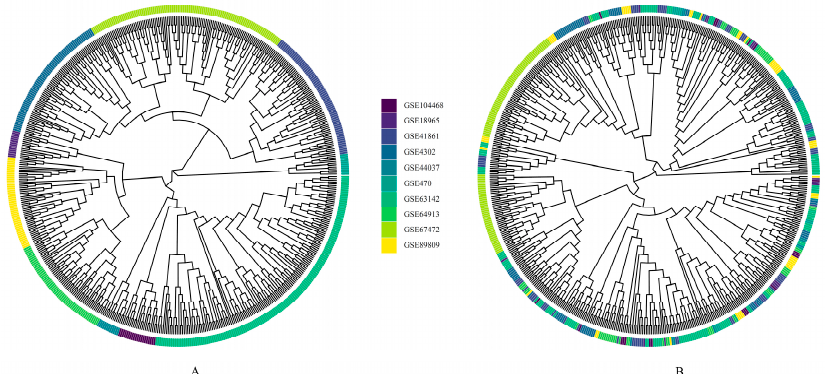
Figure 2. Exploration and visualization of the Merged dataset (abbr. DS) before and after batch correcting. Hierarchical clustering for samples was performed based on Euclidean distance and Complete linkage. Then, the results of clustering were visualized using clustering dendrograms in ggtree